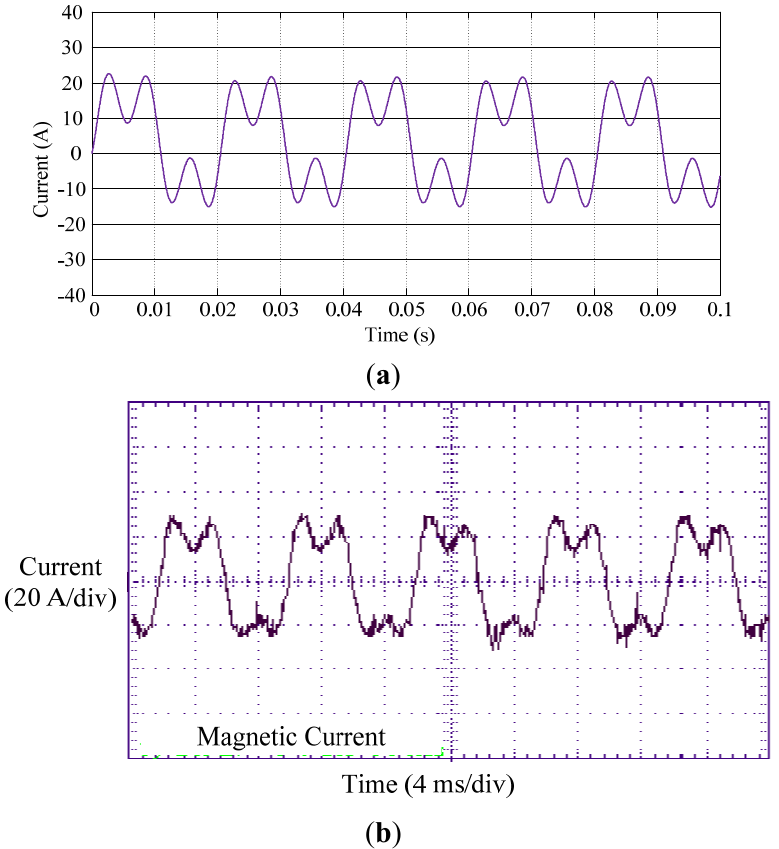
They have different values as indicated by the dashed line labeled as “Line1” in Figure 13b. The largest voltage magnitude appears in phase “c” and the lowest magnitude voltage appears in the phase “a”. Figure 12. Primary current of three-limb transformer in unbalanced condition: ( a ) Simulation; ( b ) Experiment.